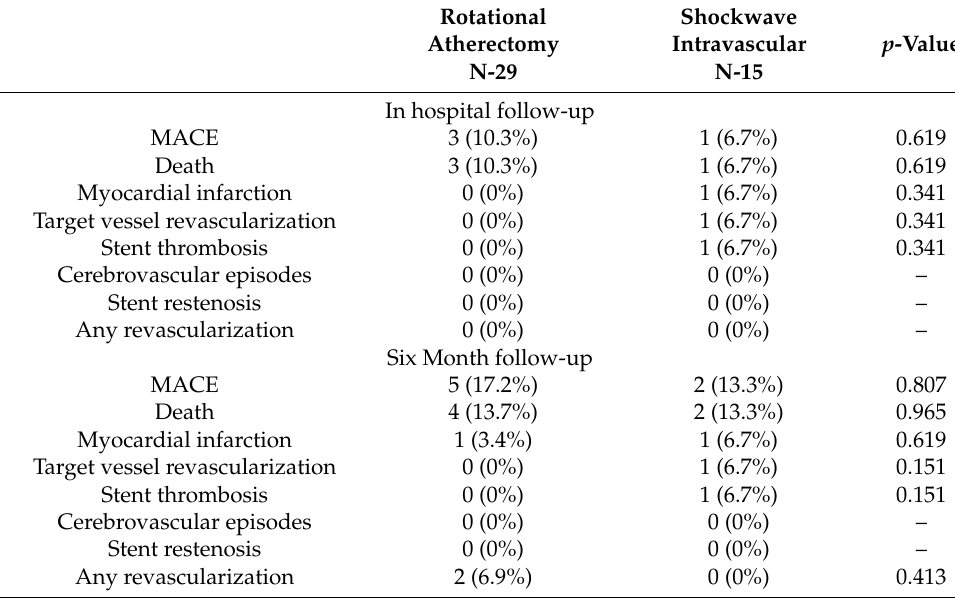
Table 3. Clinical follow-up data of both